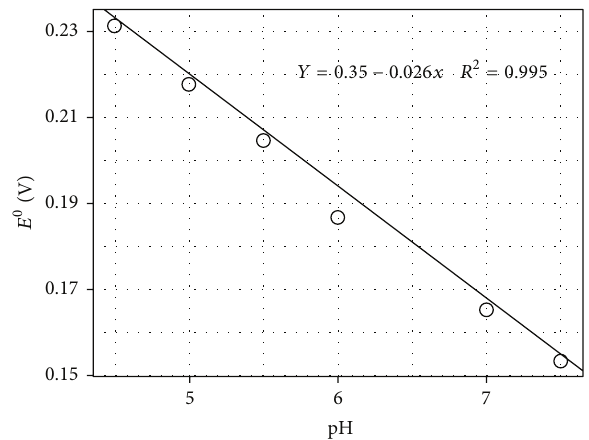
Figure 4: Tafel plot derived from the rising part of anodic voltam- mogram for Mb/PMMA- b -PDMAEMA electrode. Figure 5: pH dependence on the formal potential for Mb/PMMA- b -PDMAEMA electrode in phosphate buffer. Scan rate: 100